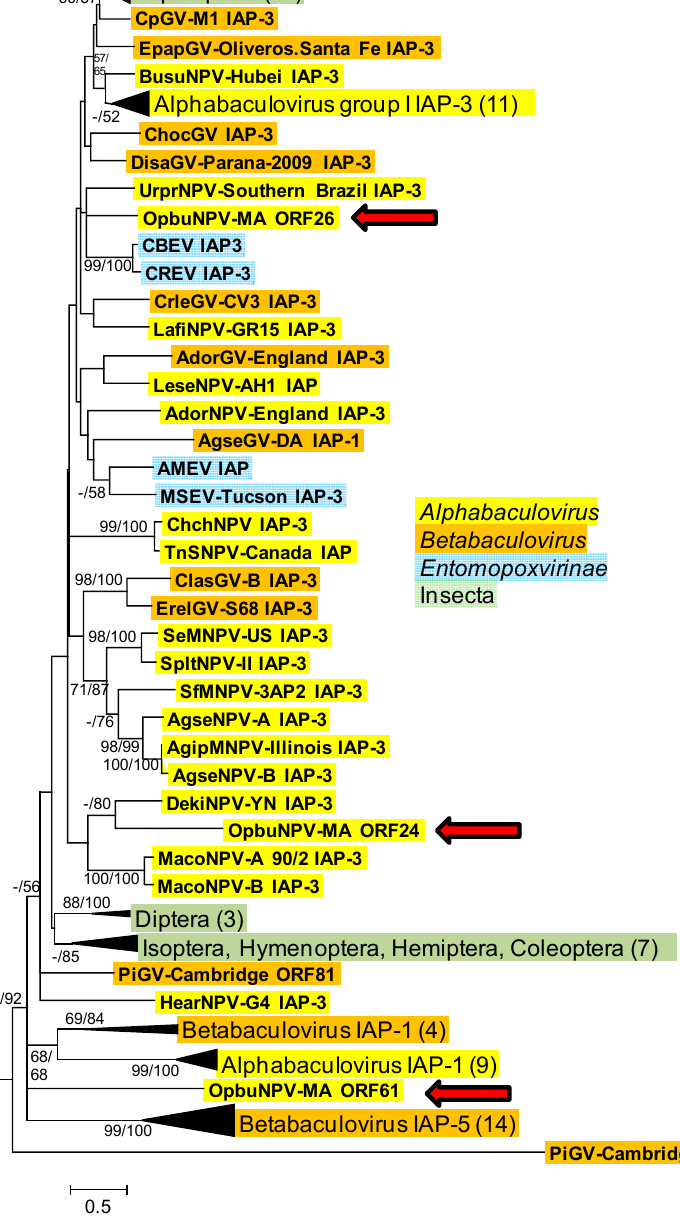
Figure 5. Phylogenetic inference from aligned viral and insect inhibitor-of-apoptosis protein (IAP) homologs. Maximum likelihood (ML) phylogram inferred from the alignment of IAP amino acid sequences is shown with bootstrap values (>50%) at interior branches for minimum evolution (ME) and ML analysis (ME/ML) where they occur. The sequence for Arabadopsis thaliana IAP-like protein (GenBank accession no. NP_173164) was used as an outgroup. The classification of each taxon is indicated with a color-coded text background. Branches for IAPs from various insect orders and for alphabaculovirus IAP-1, betabaculovirus IAP-1, betabaculovirus IAP-5, and group I alphabaculovirus IAP-3 sequences are collapsed, and the numbers of taxa in each of these nodes are indicated in parentheses. OpbuNPV sequences are indicated with red arrows. The virus and insect taxa and their accession numbers are as listed in Table S1.